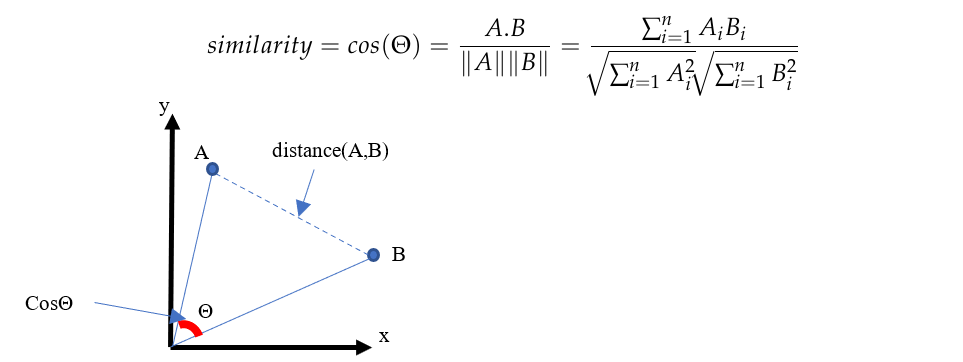
Figure 2. The illustration of cosine similarity.